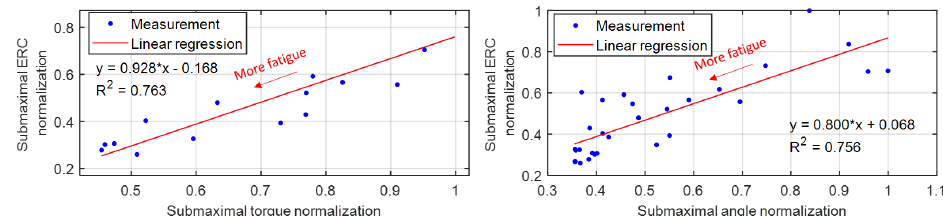
Figure 8. Linear relationships between the sub-maximal US ERC normalization and sub-maximal dorsiflexion torque/angle normalization under isometric/dynamic muscle fatigue progression condi- tions. Reported data are from Participant Sub05. Table 3. Coefficients of linear regression models ( y = ax + b ) and R 2 values between dorsiflexion torque/angle normalization and ERC